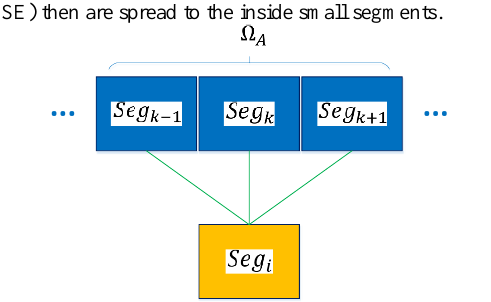
Figure 4. Pairwise registration of large segments. Seg i is the target point cloud segment, and Seg k−1 , Seg k , Seg k+1 are its overlapping